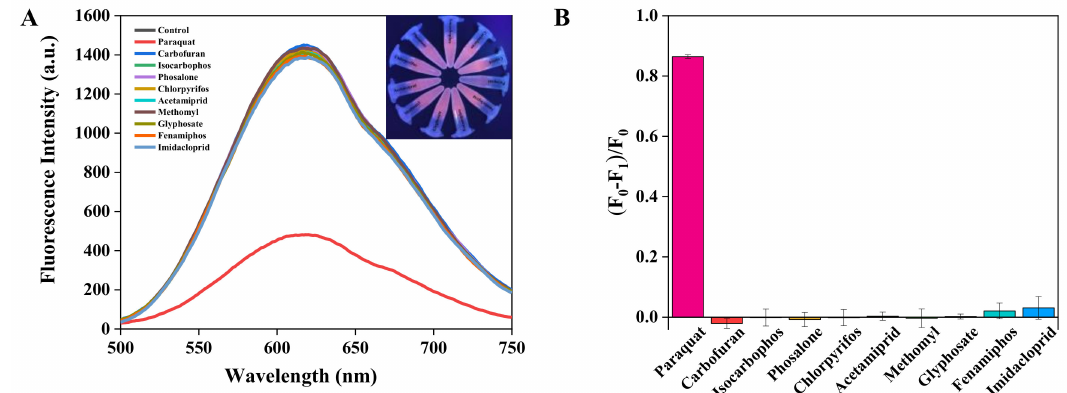
Figure 3. ( A ) Fluorescence spectra of GSH/ β -CDs-AuNCs in the presence of various pesticides. Insert picture shows the corresponding inference assay excitation at 365 nm under UV light. ( B ) Quenching efficiency of AuNCs by various pesticides. All the pesticide concentrations were 500 ng/mL.